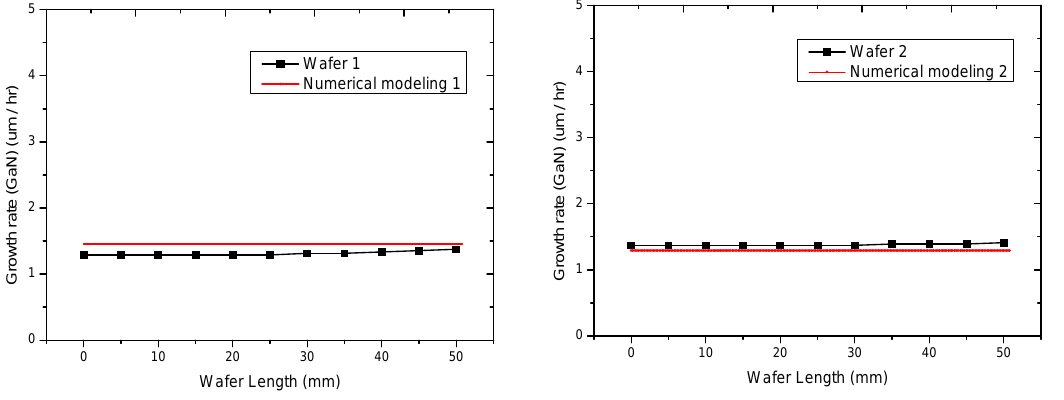
Figure 6. Predicted growth rate for wafers 1 and 2 vs. experimental results.